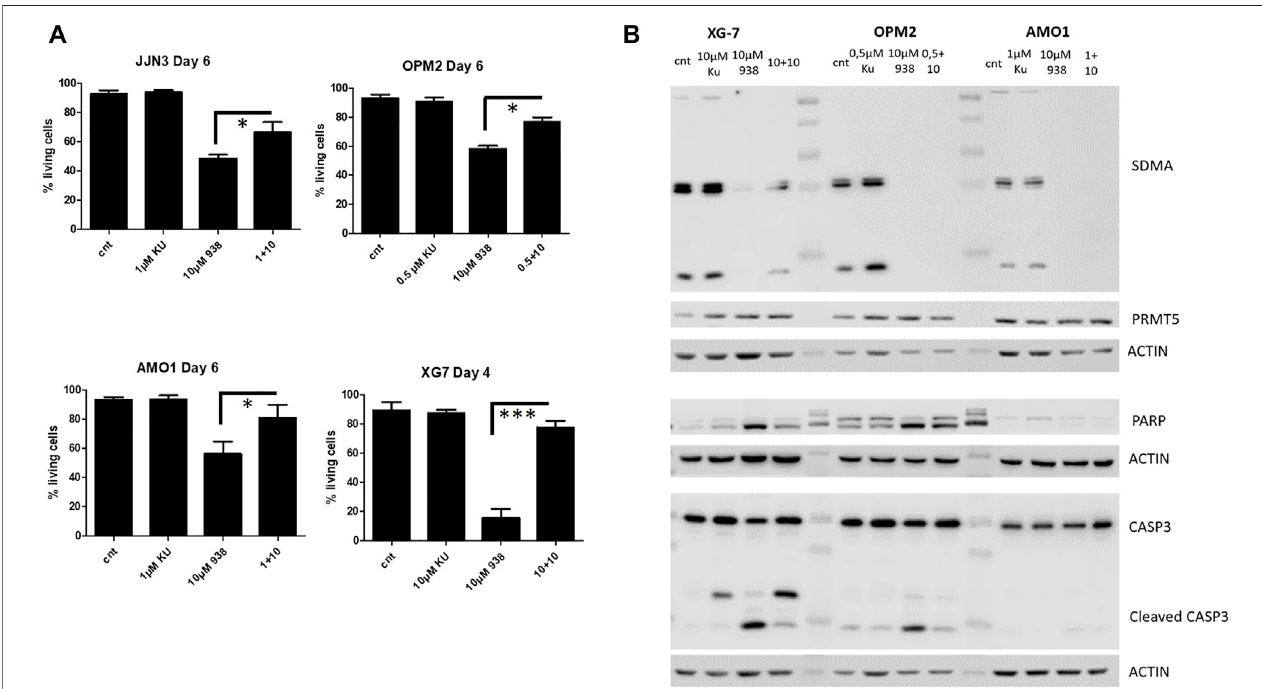
FIGURE 4 | (A) : Viability assay of HMCls upon treatment of JJN3, OPM2, AMO1 and XG7 cells with EPZ015938, KU-0063794 or combination therapy after prede fi ned timepoints. Cellular viabilitywasassessed using AnnexinV/7AADstaining.Sampleswereanalysed using anT — test with selected pairs test, signi fi cance was evaluatedbetweendifferenttreatmentsettingsandcomparedtocontrol.Errorbarsdepictmean±SD;*/**/***denotes p < 0.05, p < 0.01and p < 0.001respectively( n = 3). (B) : Western blot analysis of SDMA levels, global PRMT5 levels and pro-apoptotic proteins caspase 9, 3 and PARP in XG7, OPM2 and AMO1 cells. Cells were treated with EPZ015938, KU-0063794 or combination therapy. Control samples were included for comparison. Actin was used as a loading control. One experiment representative of 3 experiments performed is shown ( n = 3).